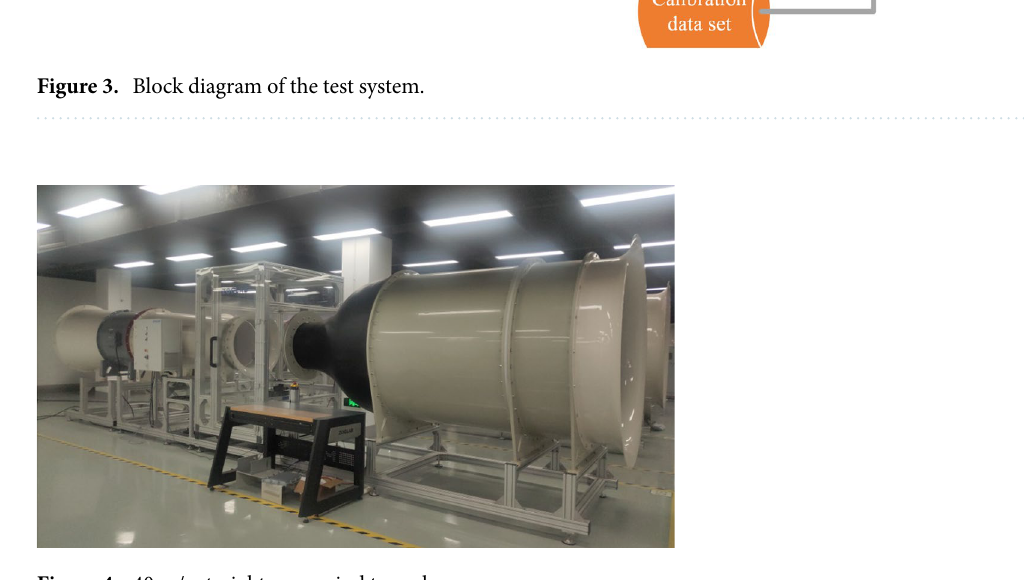
Figure 4. 40 m/s straight open wind